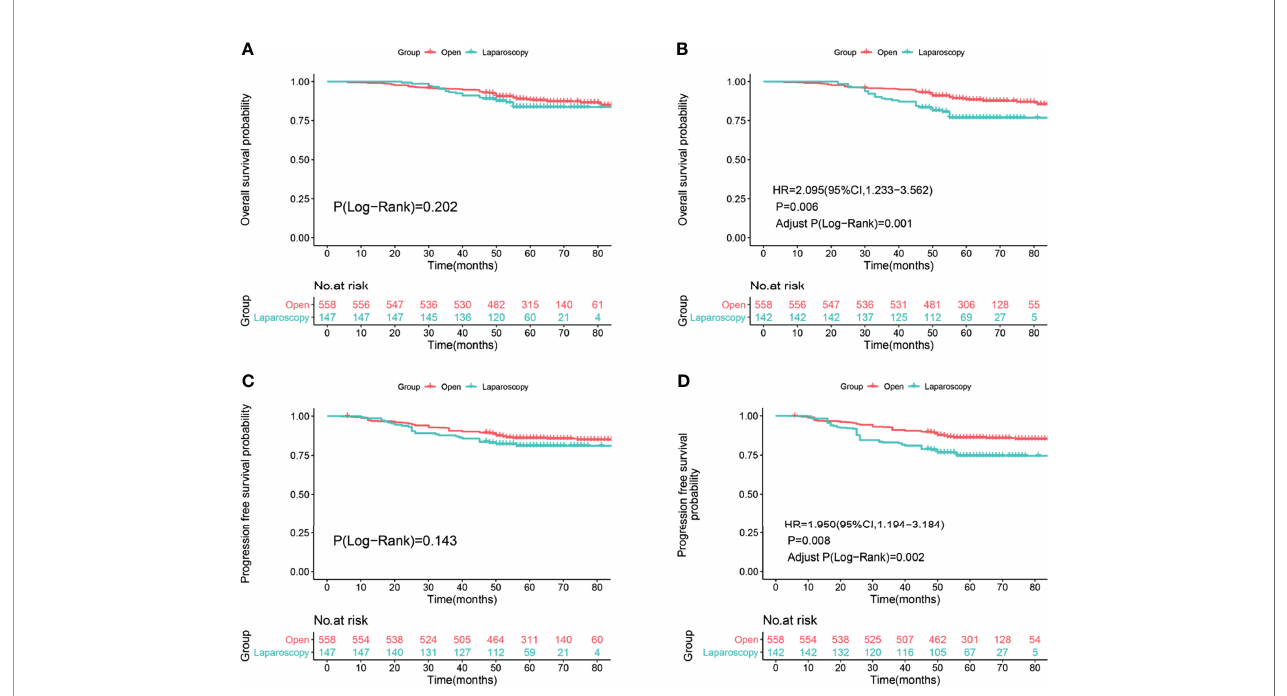
FIGURE 2 | Survival and recurrence outcomes between open and laparoscopic radically hysterectomy for stage IA2-IIA2 cervical cancer patients based on Federation International of Gynecology and Obstetrics (FIGO) 2009 staging system. (A) Overall survival (OS) curves of the patients before propensity score-based inverse probability of treatment weighting (PS-IPTW) analysis. (B) OS curves of the patients after IPTW analysis. (C) Progression free survival (PFS) curves of the patients before IPTW analysis. (D) PFS curves of the patients after IPTW